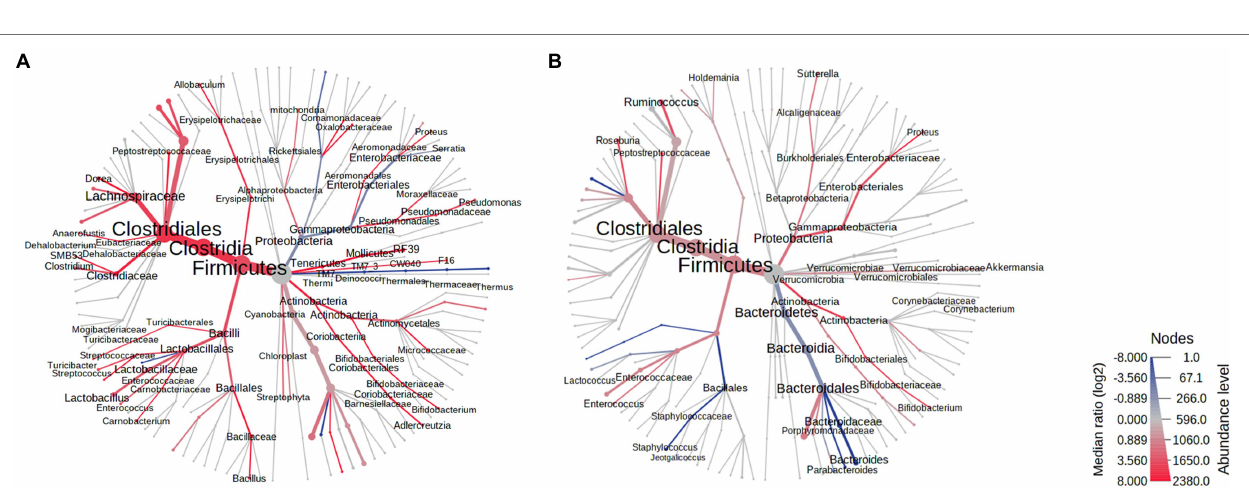
FIGURE 2 | Microbial alpha and beta diversity in stool samples from male and female control and exposed rats. (A) Stool alpha diversity in male and female control and exposed rats at baseline, on AbxD8, and on PAbxD13, as measured by Shannon’s and Simpson’s indices. (B) Stool beta diversity in male and female exposed rats at baseline and all controls (males—red and females—blue), on AbxD8 (exposed males—orange and exposed females—light blue), and on PAbxD13 (exposed males yellow and exposed females purple).